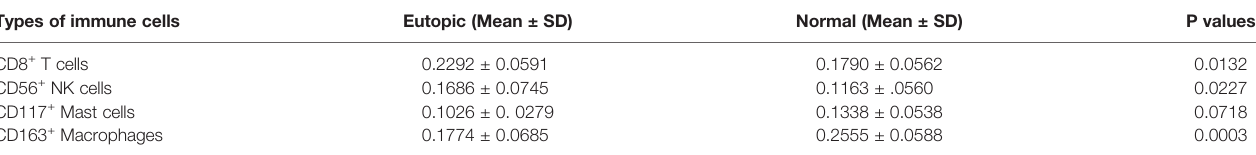
TABLE 3 | The proportions of in fi ltrating immune cells in the endometrium between normal and endometriosis. Types of immune cells Eutopic (Mean ±